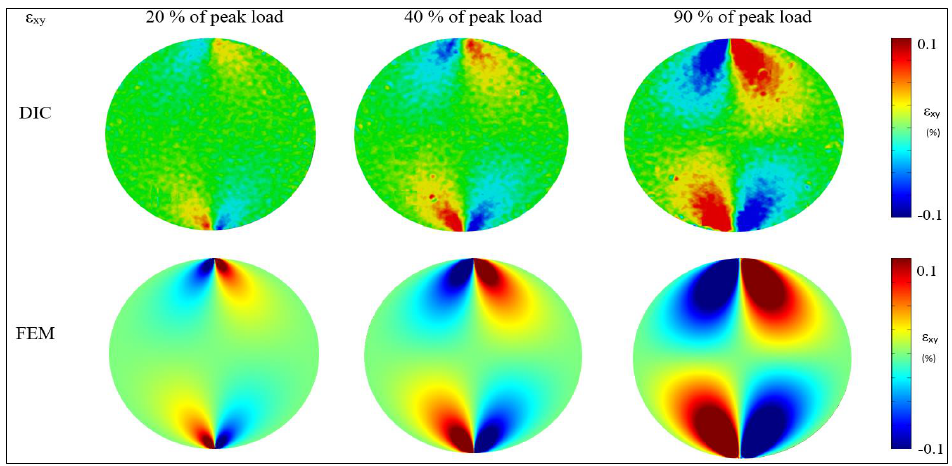
Figure 10. Shear strain ( ε xy ) distribution: DIC vs. simulation results.